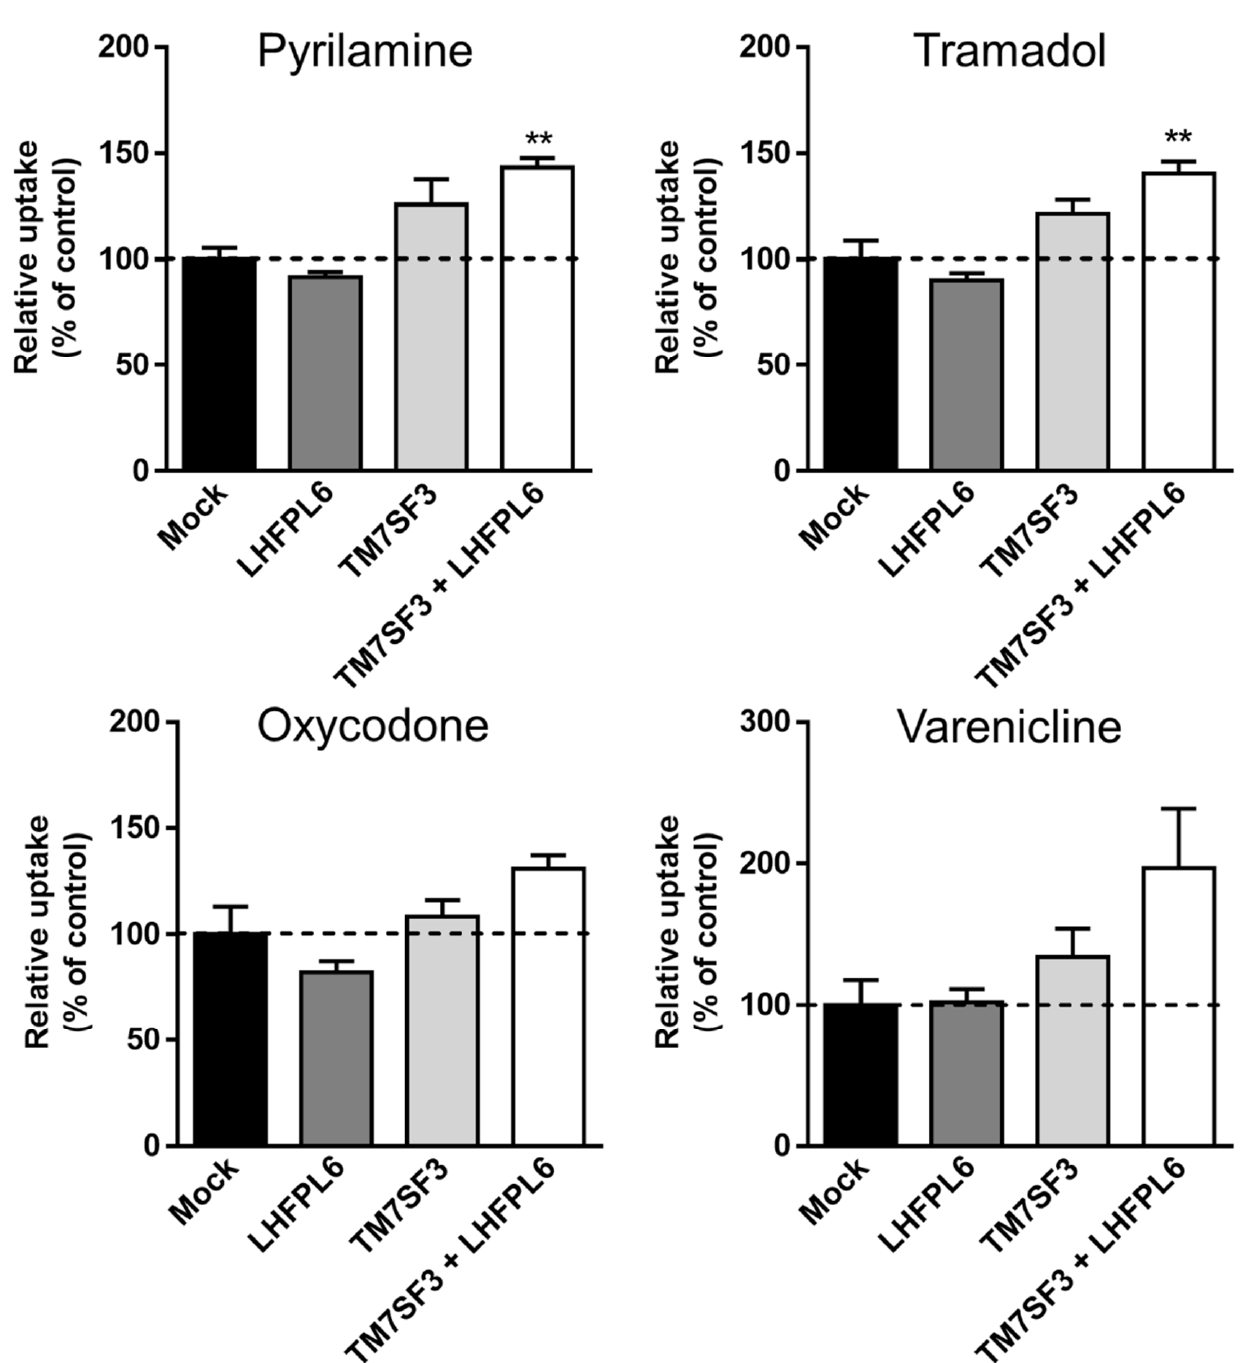
Figure 3. Uptakes of H + /OC antiporter substrates by HEK293 cells transiently transfected with LHFPL6 and/or TM7SF3. The uptake study was performed at 37 °C for 1 min in HEK293 cells transiently transfected with LHFPL6 and/or TM7SF3. Each column represents the mean ± standard error ( n = 4). ** p < 0.01, significantly different from the uptake by mock cells.